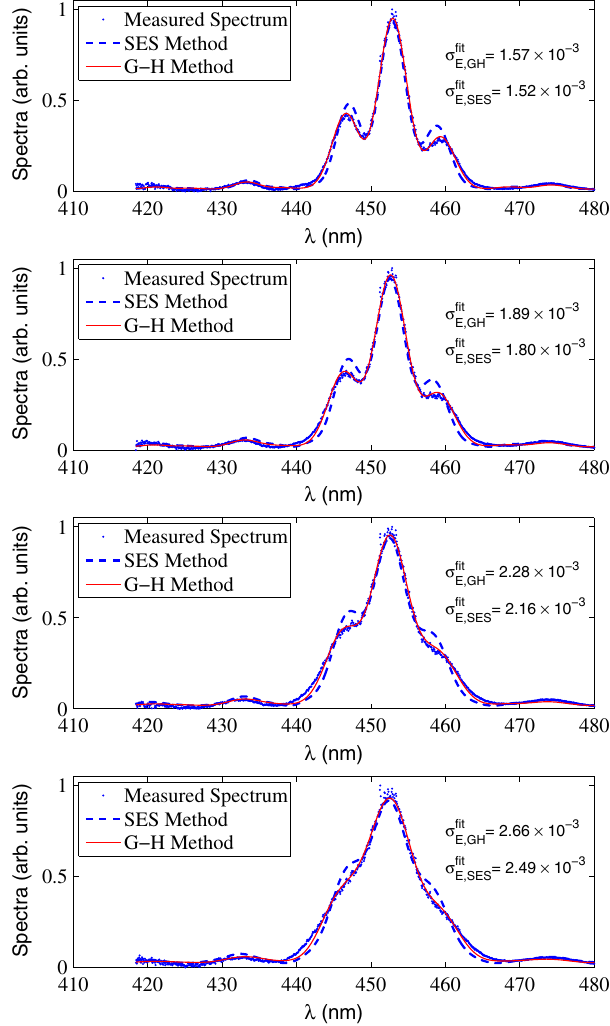
FIG. 14. (Color) Measured optical klystron spectra with a vary- ing energy spread and a high buncher setting N electron beam energy is 400 MeV and the single-bunch beam current is about 15 mA. The FEL interaction is adjusted to increase the energy spread of the beam. Both the G-H method and the SES method are used to fit the measured spectra. The fitted values of the energy spread using both methods are listed in the plot. In each subplot, the background of the measured spectrum, h in Eq. (6), has been subtracted.